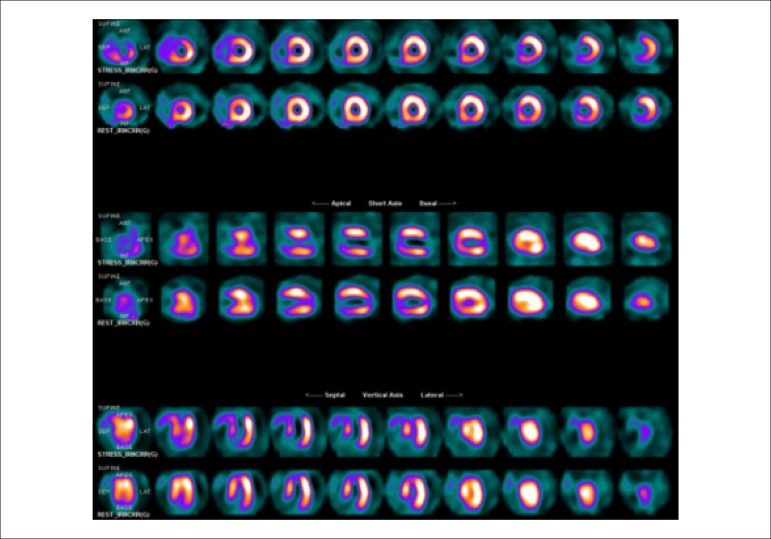
Case 12 - Myocardial perfusion scintigraphy (MPS) showing important ischemic findings (transient, stress-induced reduced uptake), with high-risk indicators, involving the territory of the left anterior descending artery (LAD). Images acquired with dedicated cardiac equipment (gamma camera), equipped with conventional sodium iodide crystals.